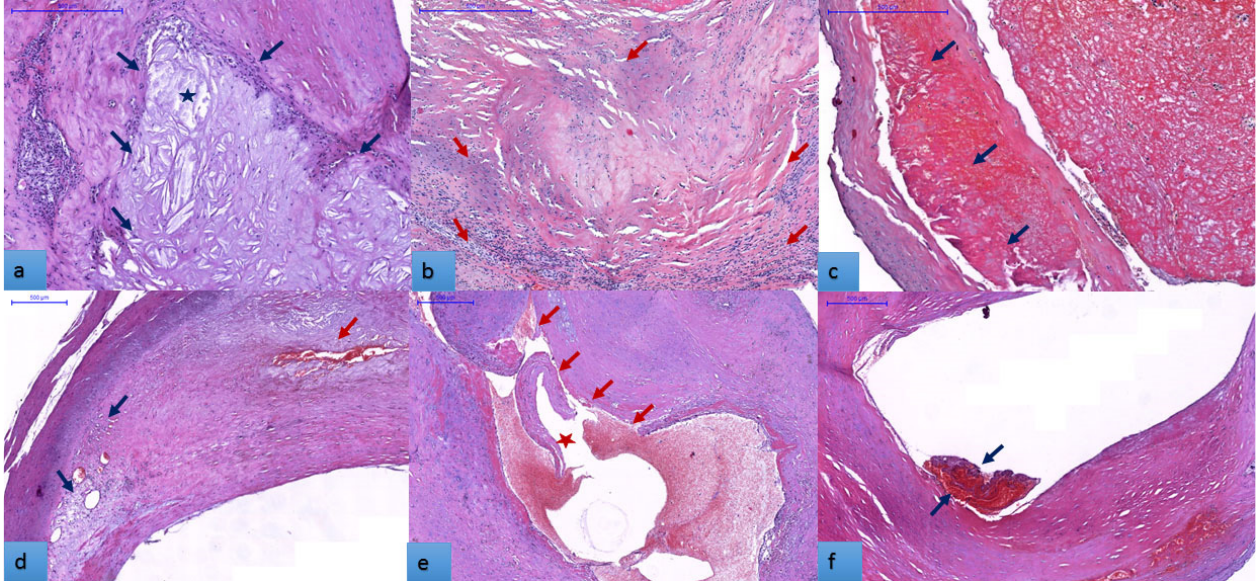
Figure 2. Representative sections of unstable carotid plaques from six different patients characterized by complex morphology and composition, H&E stain: ( a ). atherosclerotic plaque fragment with large necrotic lipid core (blue arrows; necrosis marked by star); ( b ). an abundant mononuclear inflammatory cell population (macrophages and lymphocytes) surrounds the lipid core and extends in the hyaline areas; ( c ). endarterectomy specimen shows erythrocyte aggregates in the plaque structure (intra- plaque hemorrhage) (blue arrows); ( d ). obvious intra-plaque neovascularization is seen both within and at the periphery of the plaque. The size of the neo-formed vessels varies between foci, some exceeding 10 µm (red arrow). ( e ). atheromatous plaque leading to narrowing and deformation of the lumen (blue arrows) shows fibrous cap discontinuity with an endothelial defect of at least 1000 µm in width (red arrows); ( f ). plaque ulceration in association with parietal thrombus represents a frequent cause of ischemic events. Bar represents 500 µm in all of the tissue sections.